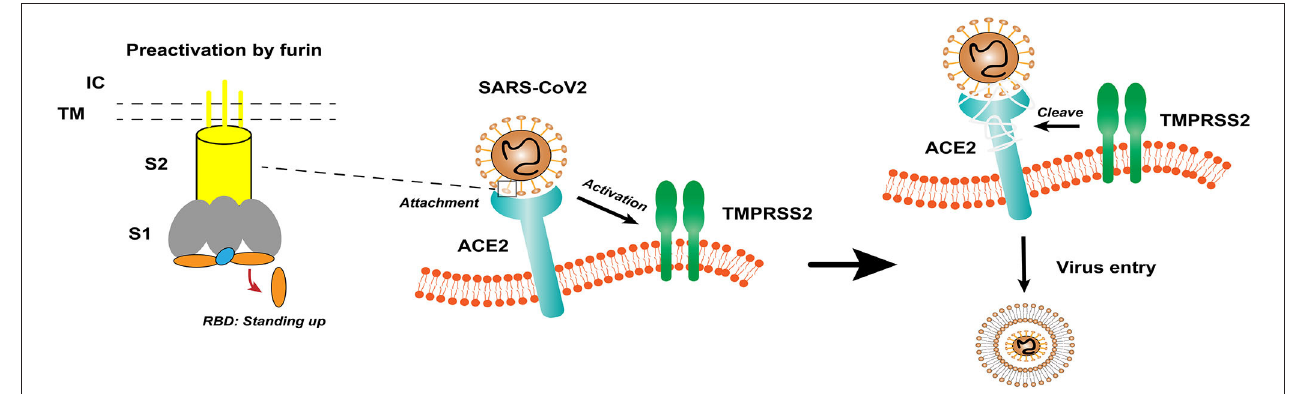
FIGURE 1 | The structure of coronavirus spikes includes: S1, S2, TM, IC, RBD. The RBD hidden in the spikes for immune evasion. When recognizing the ACE2 receptor, the RBD stands up to bind the receptor. The furin pre-activation of the spike can enhance the ability of the virus to enter certain cells. At the cell membrane, SARS-CoV-2 recognizes the ACE2 receptor and recruits TMPRSS2. TMPRSS2 facilitates viral entry and spreads into the host cell by cleaving ACE2 and S protein. S1, receptor-binding subunit 1; S2, membrane fusion subunit 2; TM, transmembrane anchor; IC, intracellular tail; RBD, receptor-binding domain; ACE2, angiotensin-converting enzyme 2; SARS-CoV-2, Severe Acute Respiratory Syndrome Coronavirus 2; TMPRSS2, type II transmembrane serine